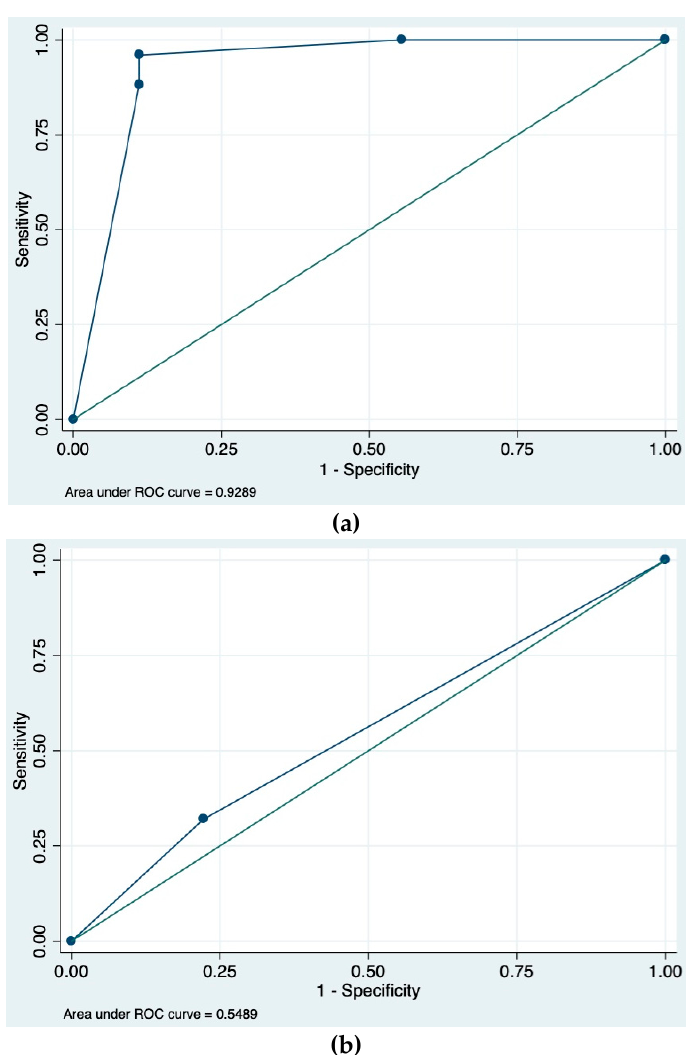
Figure 2. ( a ) The area under the receiver operating characteristic (ROC) curve for combined expert and novice mucosal protrusion angle using a cutoff of <90 ◦ for true mass. ( b ) The area under the ROC curve for smooth, protruding lesion at capsule endoscopy (SPICE) index using a cutoff of >2 for true